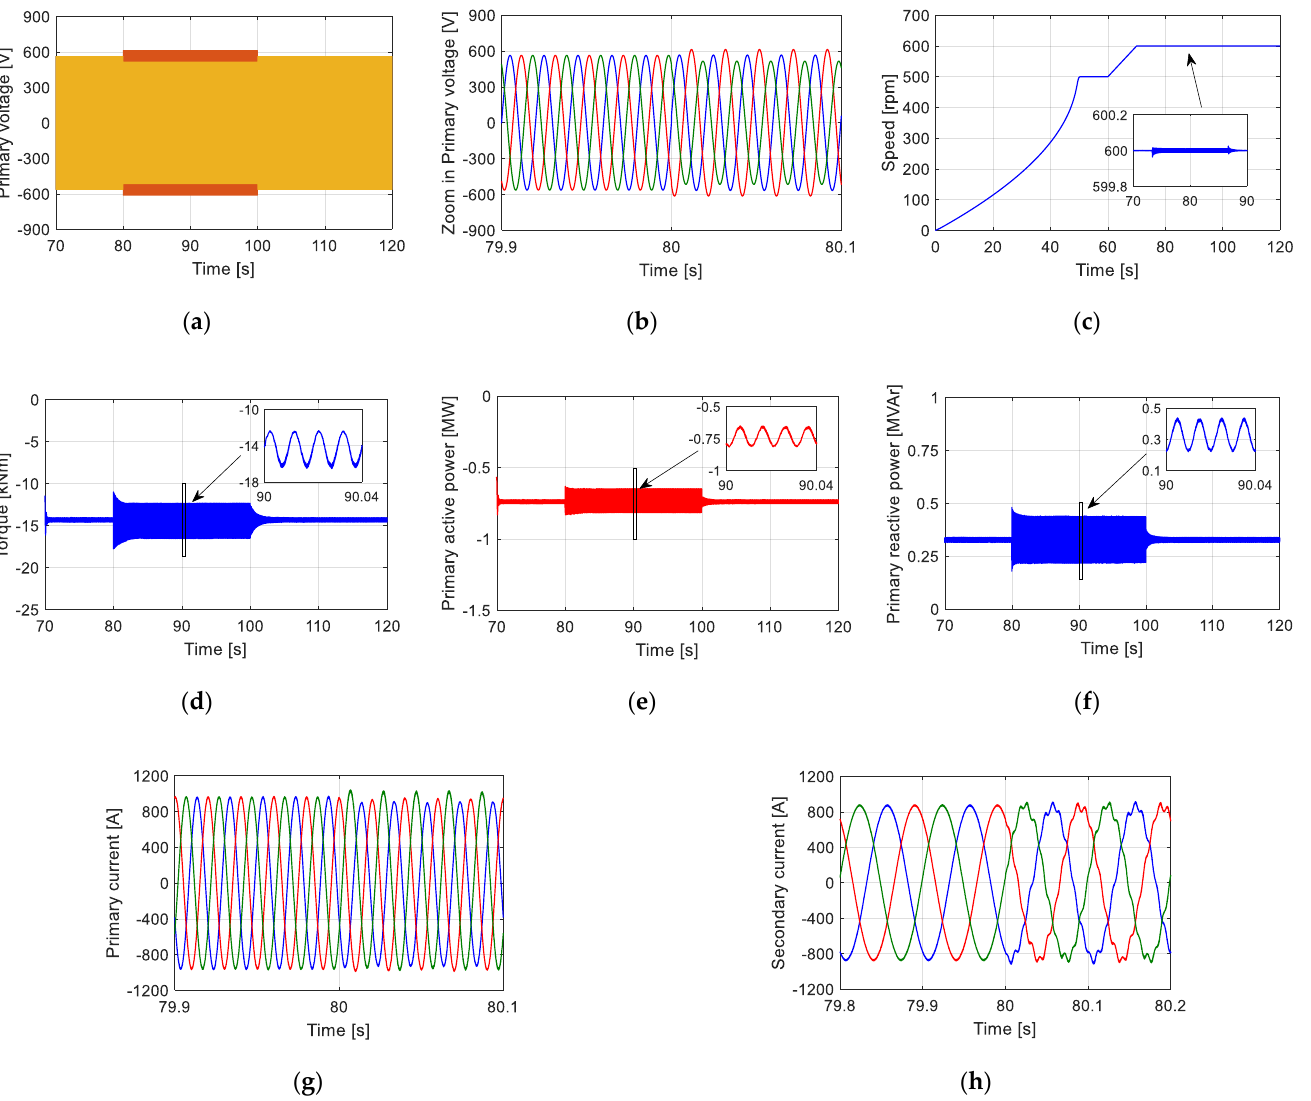
Figure 6. Simulated results with conventional control under transient primary voltage unbalance of 10% VUF during 80 – 100 s, with a constant rotor speed at 600 rpm; ( a ) primary voltage profile; ( b ) transient transaction period between normal and unbalanced conditions; ( c ) speed curve of the BDFRG; ( d ) electromagnetic torque; ( e ) primary active power; ( f ) primary reactive power; ( g ) transient period between normal and unbalanced conditions for the primary current; ( h ) transient period for the secondary current.